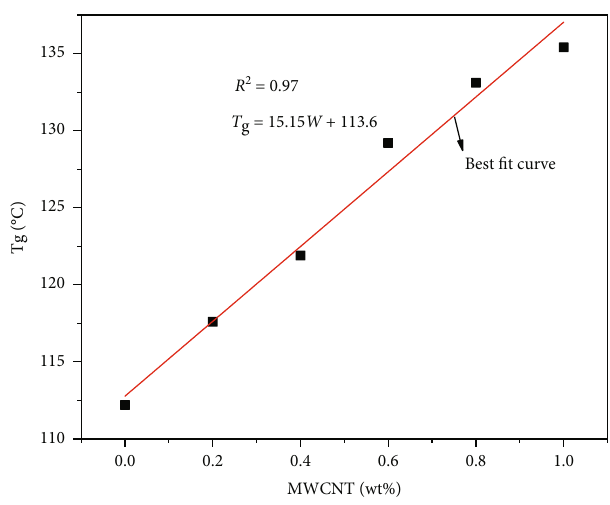
Figure 7: Glass transition temperature of nanocomposites.